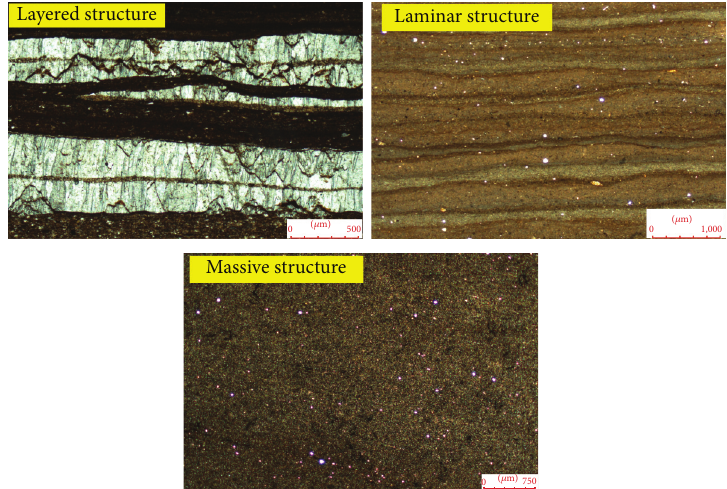
Figure 1: Structure characteristics of shale oil reservoir samples